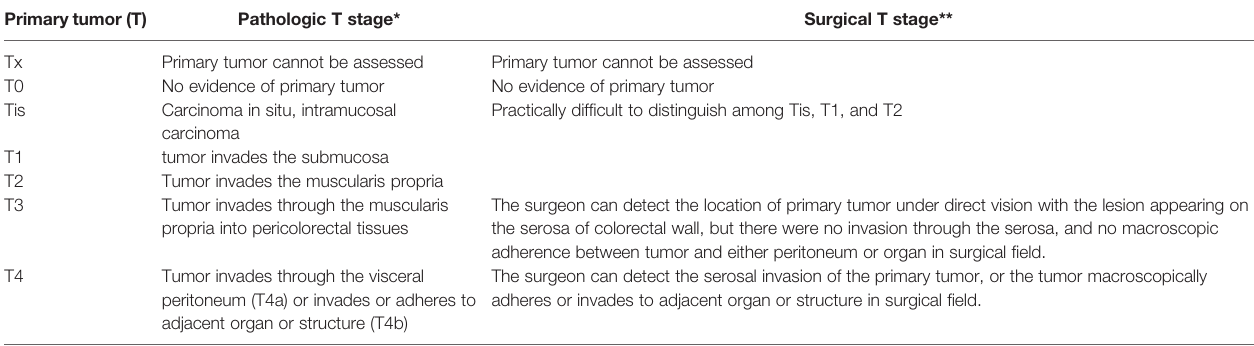
TABLE 1 | Comparison between the pathologic T stage* and surgical T stage** in primary tumor (T) staging of patients with right colorectal cancer. Primary tumor